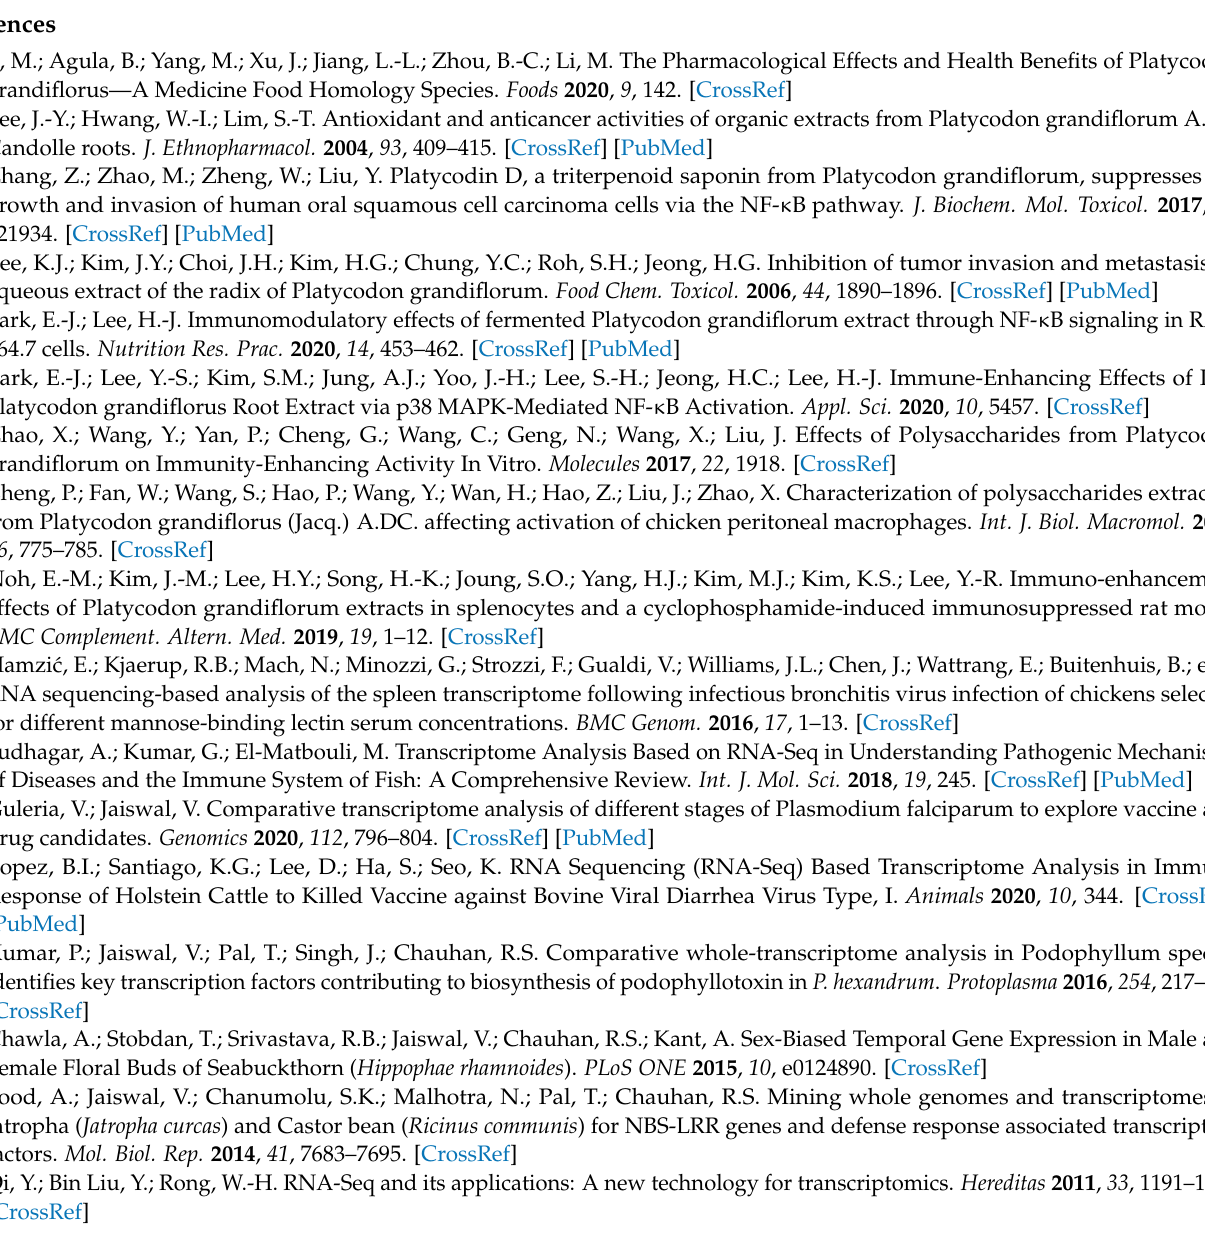
comparison-II, Table S6: Network stats of protein-protein interaction network from STRING, Table S7: KEGG enrichment analysis of 126 immunosuppressive genes in STIRNG server, Table D1: Results of differential expression in comparison-I, Table D2: Results of differential expression in